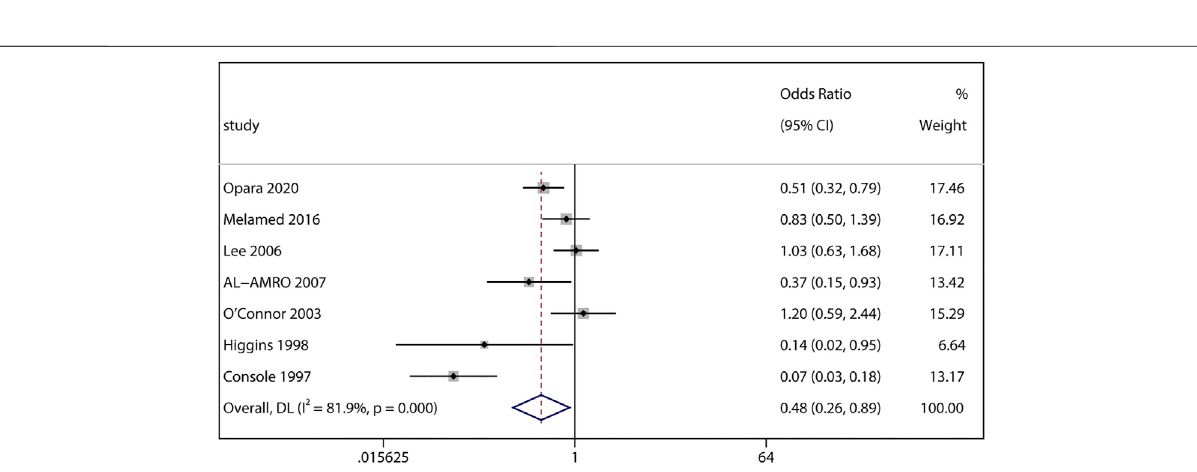
Frontiers in Pharmacology |